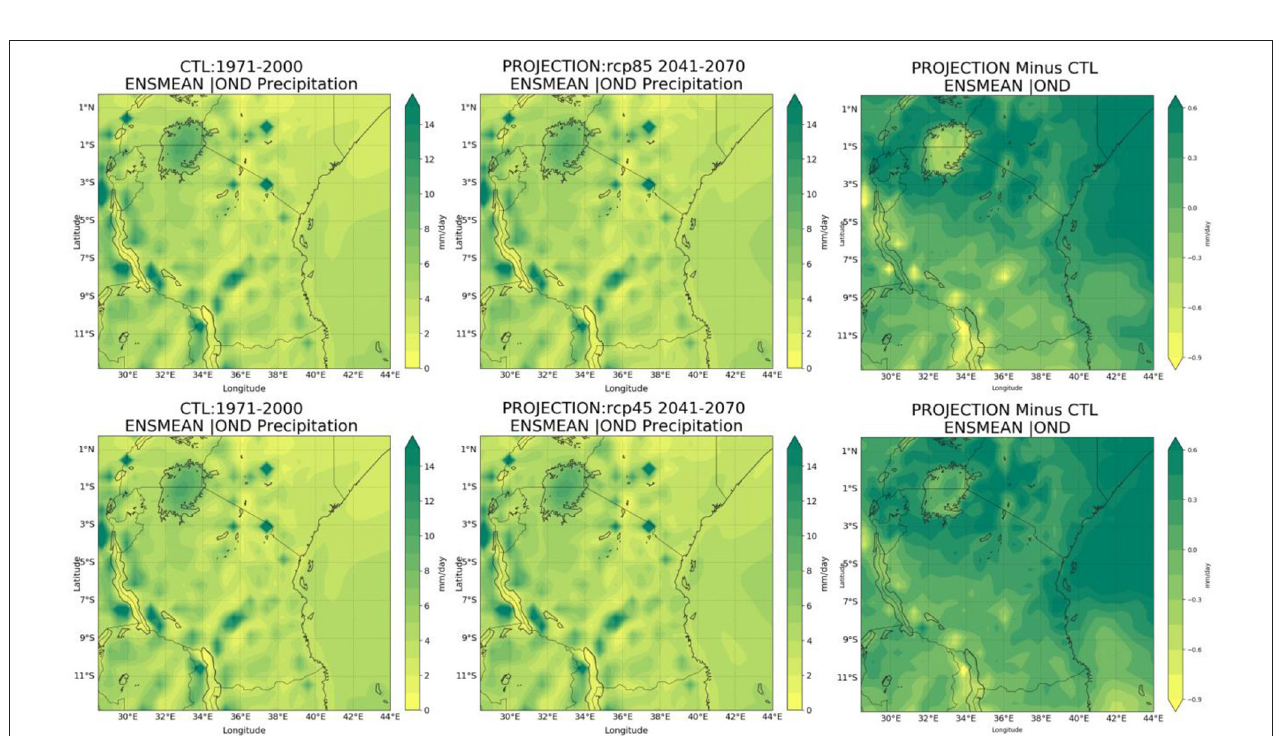
FIGURE 13 | Precipitation in mm/day for OND during base period (1971–2000), mid century (2041–2070), and change in precipitation under both RCP8.5 (upper) and RCP 4.5 (lower) .